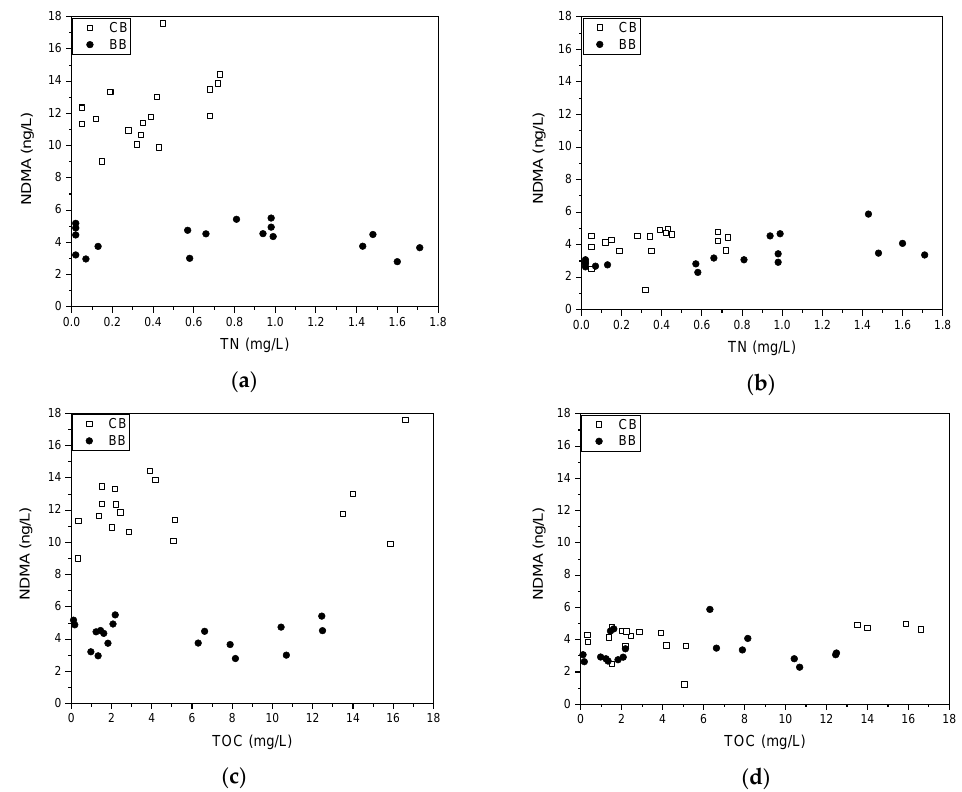
Figure 5. Scatter plots showing no relationships between TN and NDMA, and TOC and NDMA. ( a ), ( c ) = 24 h CT; ( b ), ( d ) = 72 h CT. CB = Cork Brook, BB = Bailey Brook.